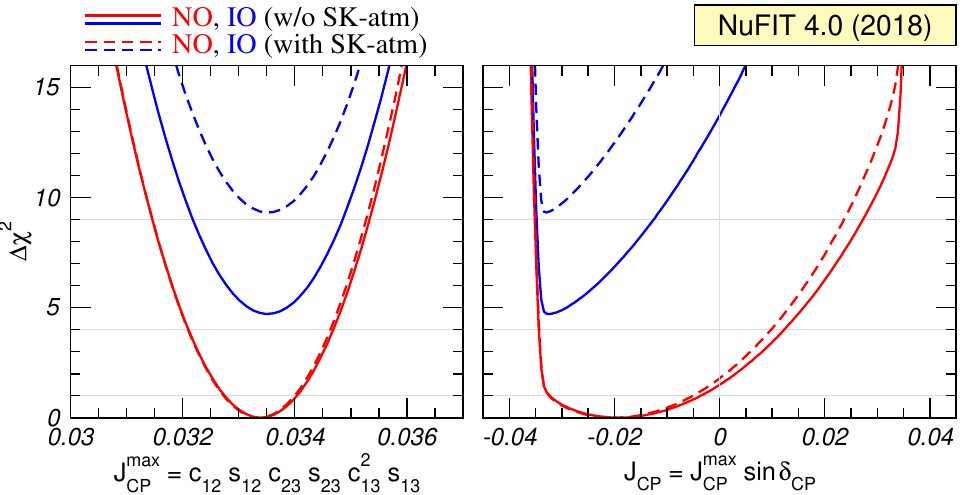
Figure 3 . Dependence of the global (cid:1) (cid:31) 2 function on the Jarlskog invariant. The red (blue) curves are for NO (IO). Solid (dashed) curves are without (with) adding the tabulated SK-atm (cid:1) (cid:31) 2